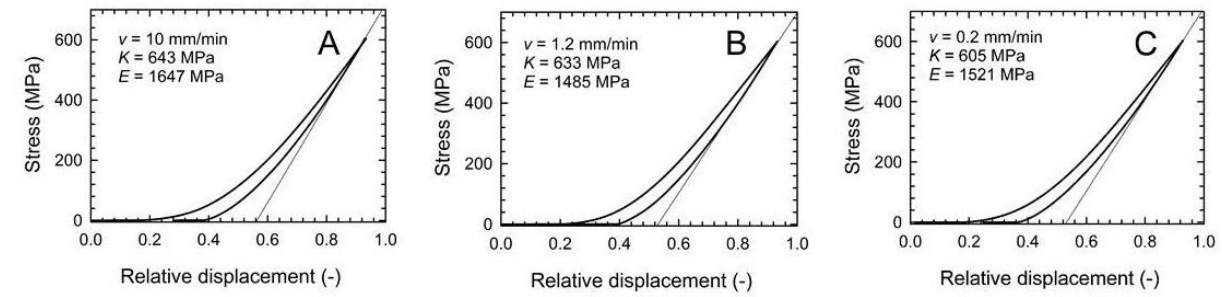
Figure 7: Stress vs relative displacement dependencies observed for hollow spheres calcium carbonate filler (sample 1) during chamber uniaxial compression testing (at 80 kN compression force): A - 10 mm/min deformation rate, B - 1.2 mm/min deformation rate and C. - 0.2